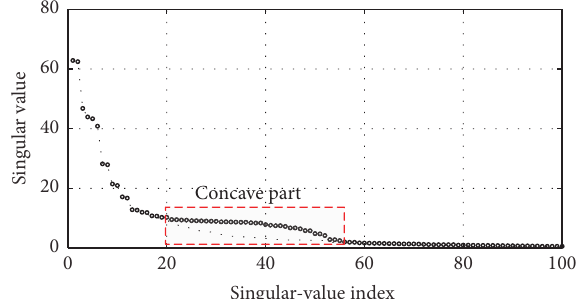
Figure 10: Singular spectrum with a concave part due to embedding watermark bit 1 .